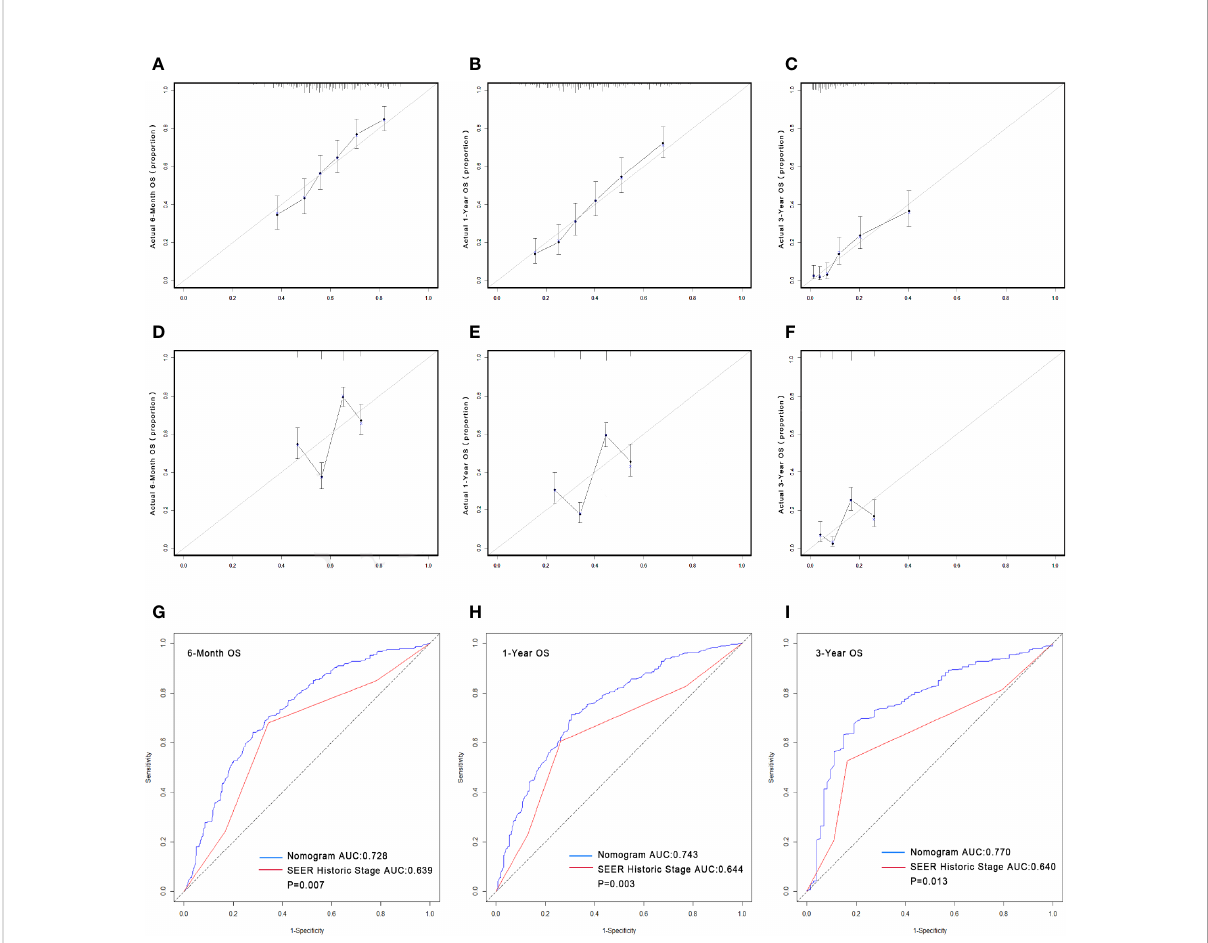
FIGURE 2 Calibrations of the nomograms and stage for predicting survival rates (A – F) . The x-axis represents the nomogram-predicted survival rates, whereas the y-axis represents the actual survival rates. All predictions lie within a 10% margin of error (within the dashed lines). (A) Calibration of the nomogram for predicting the 6-month OS rate. (B) Calibration of the nomogram for predicting the 1-year OS rate. (C) Calibration of the nomogram for predicting the 3-year OS rate. (D) Calibration of the stage for predicting the 6-month OS rate. (E) Calibration of the stage for predicting the 1-year OS rate. (F) Calibration of the stage for predicting the 3-year OS rate. Comparison of the AUCs of the nomogram and SEER historic stage for predicting survival rates. The blue lines represent nomogram predicted survival rates, whereas the red lines represent SEER historic stage predicted survival rates. AUCs of the two models predict OS rates at 6 months (G) , 1 year (H) and 3 years (I) . OS, overall survival; AUC, area under the curve; SEER, Surveillance, Epidemiology, and End